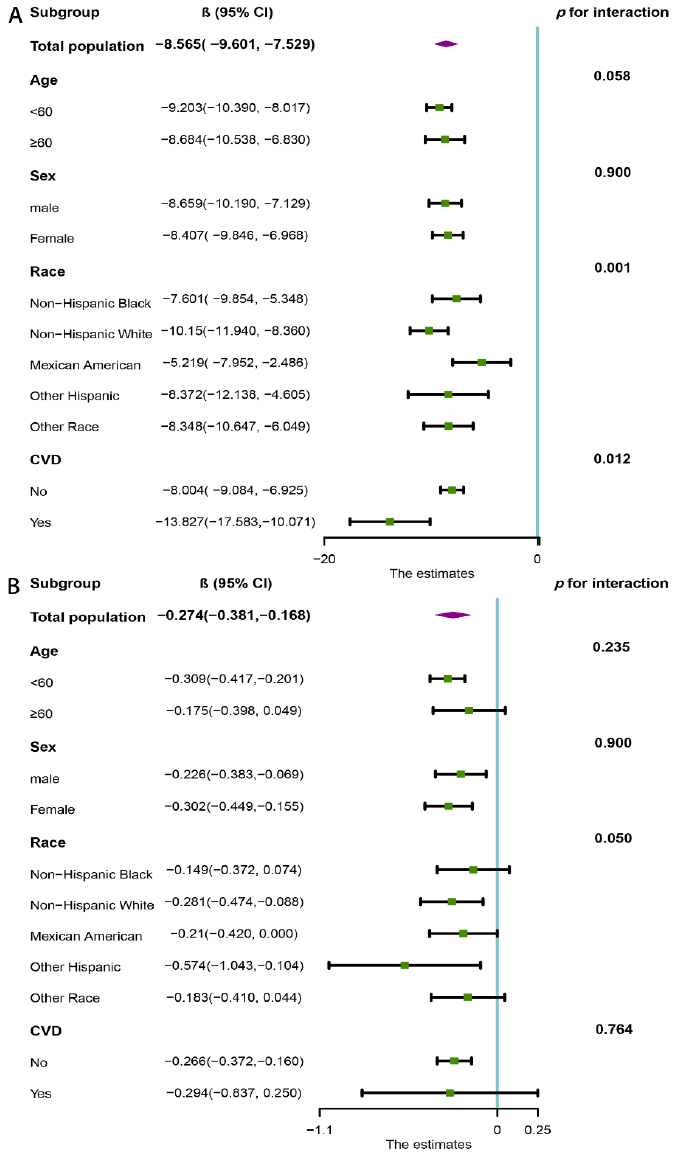
Figure 3. Subgroup analysis of the association of CVH metrics with ( A ) CAP and ( B ) LSM. The results were adjusted for all covariates except for the corresponding stratification variable. CVH, cardiovascular health; CAP, controlled attenuation parameter; LSM, liver stiffness measure.